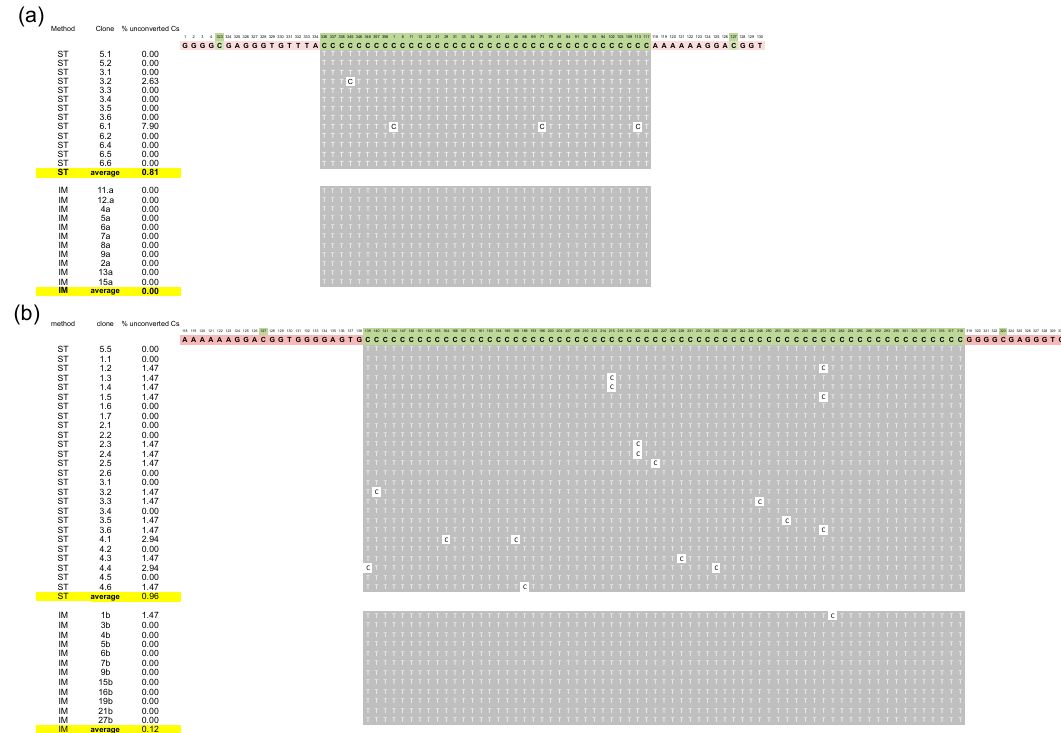
Figure 2. Bisulfite sequencing of + PSTVd RNAs. Bisulfite cytosine conversion generated by the standard (St) and the improved (Im) protocols of two + PSTVd fragments amplified with the primer pairs PSTVd_met_1F_plus / PSTVd_met_2R_plus and PSTVd_met_3F_plus / PSTVd_met_4R_plus (panel ( a , b ), respectively). The sequences targeted by the specific primers (salmon background) and the positions of cytosines in the reference variant PSTVd-Nb (green background) are indicated on the top. Converted (T, grey background) and unconverted (C, white background) cytosines are reported for each sequenced clone, the name of which is reported on the left, together with the percentage of unconverted cytosines. Supplementary Materials: The following are available online at www.mdpi.com/xxx/s1, Figure S1 Bisulfite sequencing of - PSTVd RNAs. Bisulfite cytosine conversion generated by the standard (St) and the improved (Im) protocols of a - PSTVd fragment amplified with the primer pair PSTVd_met_5F_minus/PSTVd_minus_6R_plus. The sequences targeted by the specific primers (salmon background) and the positions of cytosines in the reference variant PSTVd-Nb (green background) are indicated on the top. Converted (T, grey background) and unconverted (C, white background) cytosines are reported for each sequenced clone, the name of which is reported on the left, together with the percentage of unconverted cytosines. Figure S2 Bisulfite sequencing of + and - ASBVd RNAs. Bisulfite cytosine conversion generated by the standard (St) and the improved (Im) protocols of + and - PSTVd fragments amplified with the primer pairs ASBVd_met_1F_plus/ ASBVd _met_2R_plus and ASBVd _met_3F_minus/ ASBVd _met_4R_minus (panel A and panel B, respectively). The sequences targeted by the specific primers (salmon background) and the positions of cytosines in the reference variant ASBVd (green background) are indicated on the top. Converted (T, grey background) and unconverted (C, white background) cytosines are reported for each sequenced clone, the name of which is reported on the left, together with the percentage of unconverted cytosines. Figure S3 Bisulfite sequencing of + HSVd in vitro transcript. Bisulfite cytosine conversion generated by the standard (St) and the improved (Im) protocols of a + HSVd fragment amplified with the primer pair HSVd_met_1F_plus/HSVd_plus_2R_plus. The sequences targeted by the specific primers (salmon background) and the positions of cytosines in the reference variant HSVd (green background) are indicated on the top. Converted (T, grey background) and unconverted (C, white background) cytosines are reported for each sequenced clone, the name of which is reported on the left, together with the percentage of unconverted cytosines.